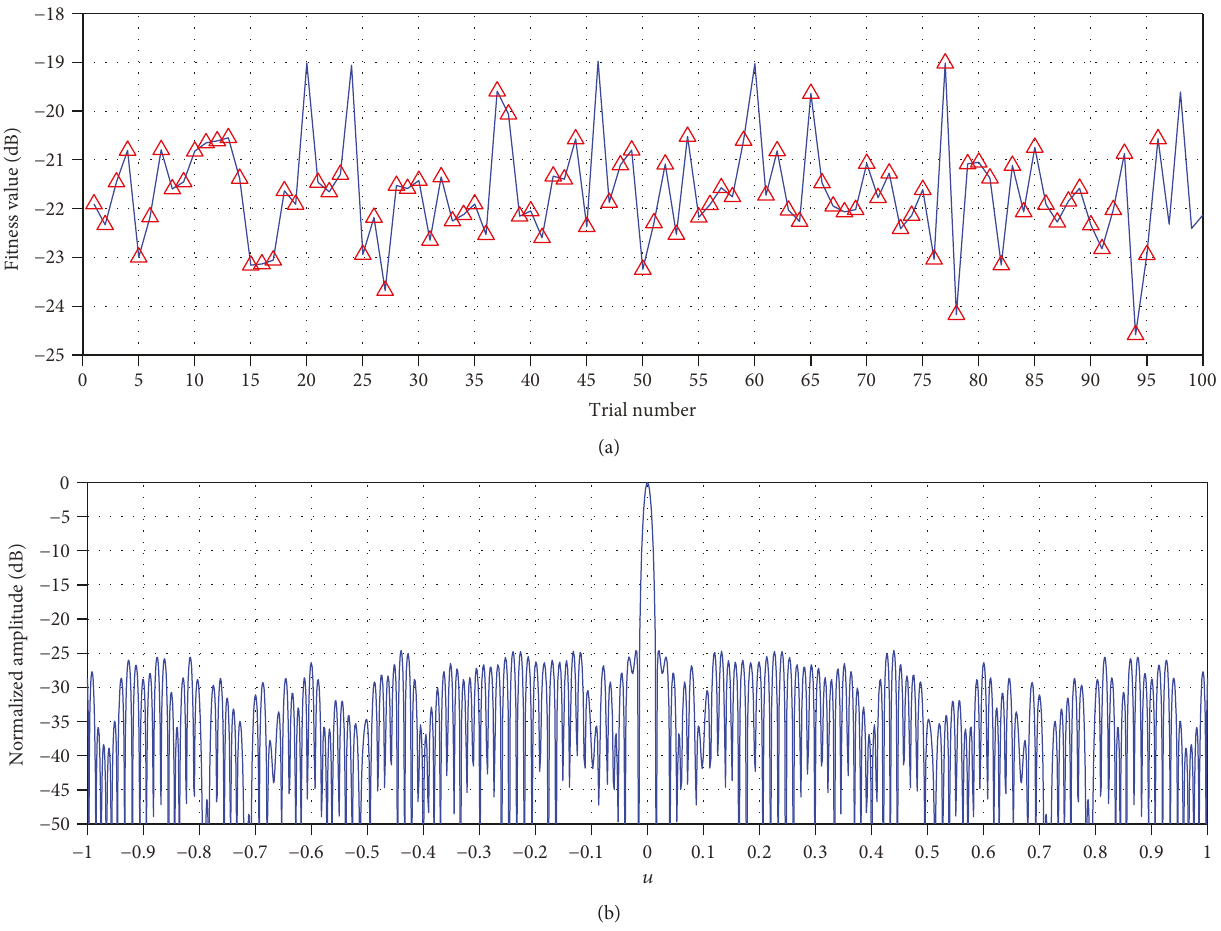
Figure 2: The sparse linear array obtained by the IFT-DE based on a symmetrical TLA with a fi lling factor of 66%. (a) The convergence curve of the fi tness value. (b) The optimal far- fi eld pattern among 100